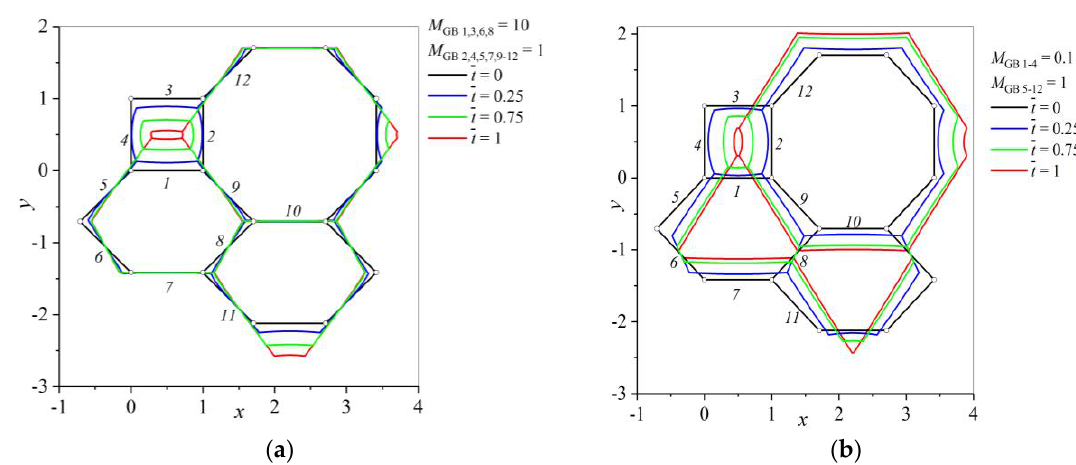
Figure 11. Evolution of the grain arrangement for different normalized times t . ( a ) Case XI: The mobilities M T 1–8 are set to value 100, whereas the mobilities of grain boundaries from the eight-sided grain IV M GB 2,4,5,7,9–12 are set to 1 and the remaining grain boundary mobilities M GB 1,3,6,8 are set to 10. ( b ) Case XII: The mobilities M T 1–8 are set to value 100, grain boundary mobilities of the four sided grain I M GB 1–4 are set to 0.1 and the remaining grain boundary mobilities M GB 5–12 are set to 1.